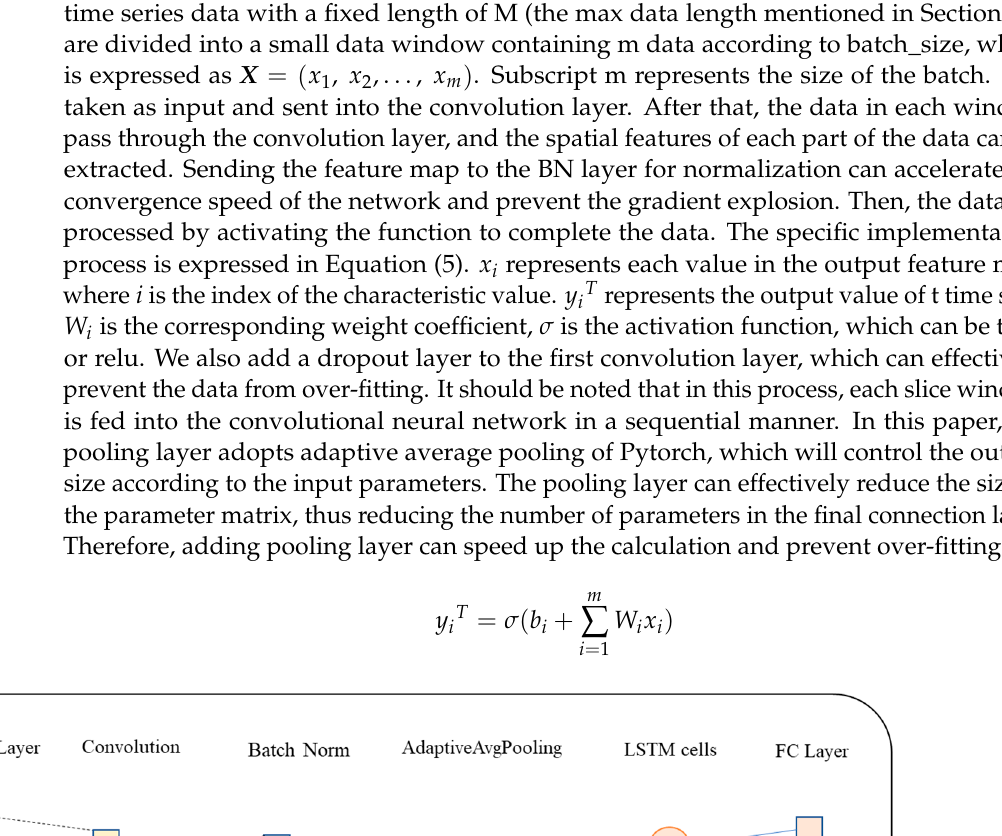
Figure 4. The simple flow chart of the proposed anomaly detection.